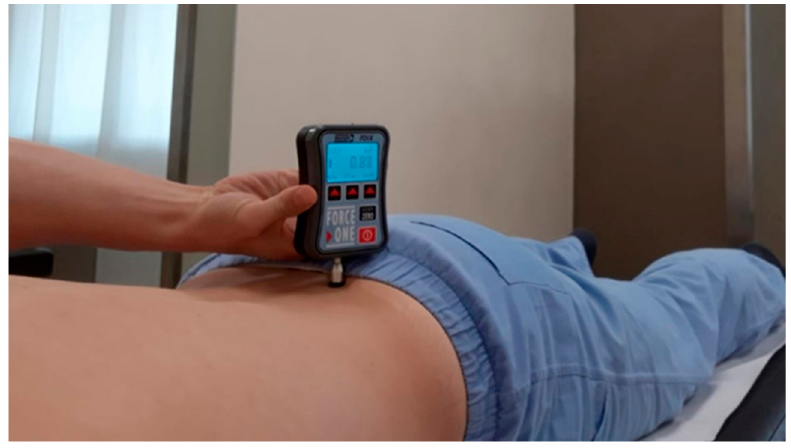
Figure 1. Algometer positioned at the level of the posterior inferior iliac spine (PIIS). All initial data and subsequent evaluations were collected by the same physiotherapist (DB), while all treatments were performed by a second physiotherapist (LS), who has extensive experience in Fascial Manipulation ®